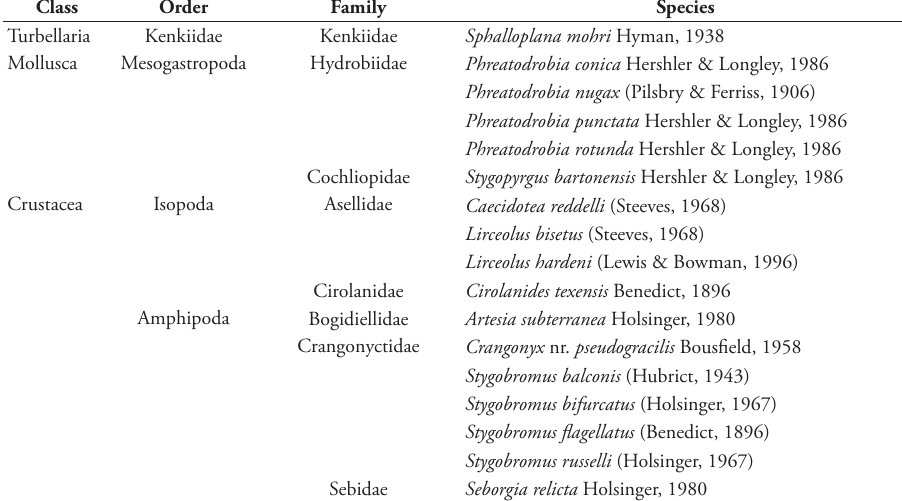
Table 1. Stygobiontic invertebrate fauna recorded in the Austin-Round Rock Metro area, Texas, USA.